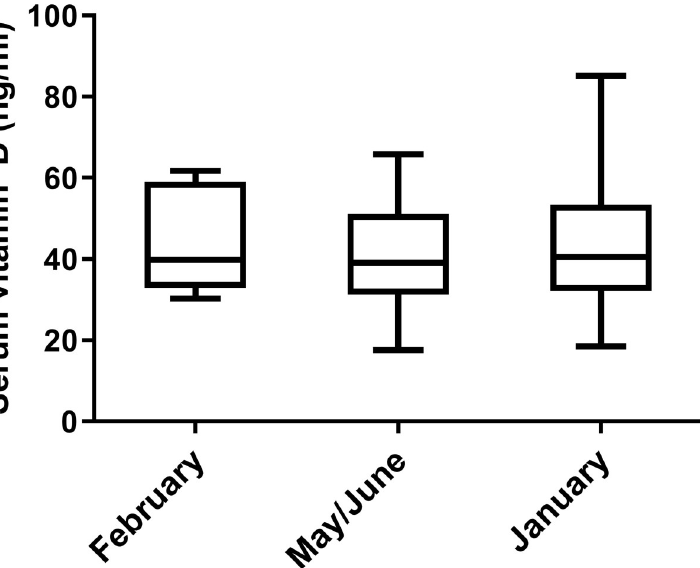
Fig 1. Serum Vitamin D levels of 36 healthy dogs living in Spain at three different time points. Vitamin D status in dogs was assessed according to the serum levels of 25-hydroxyvitamin D estimated with an ELISA test.